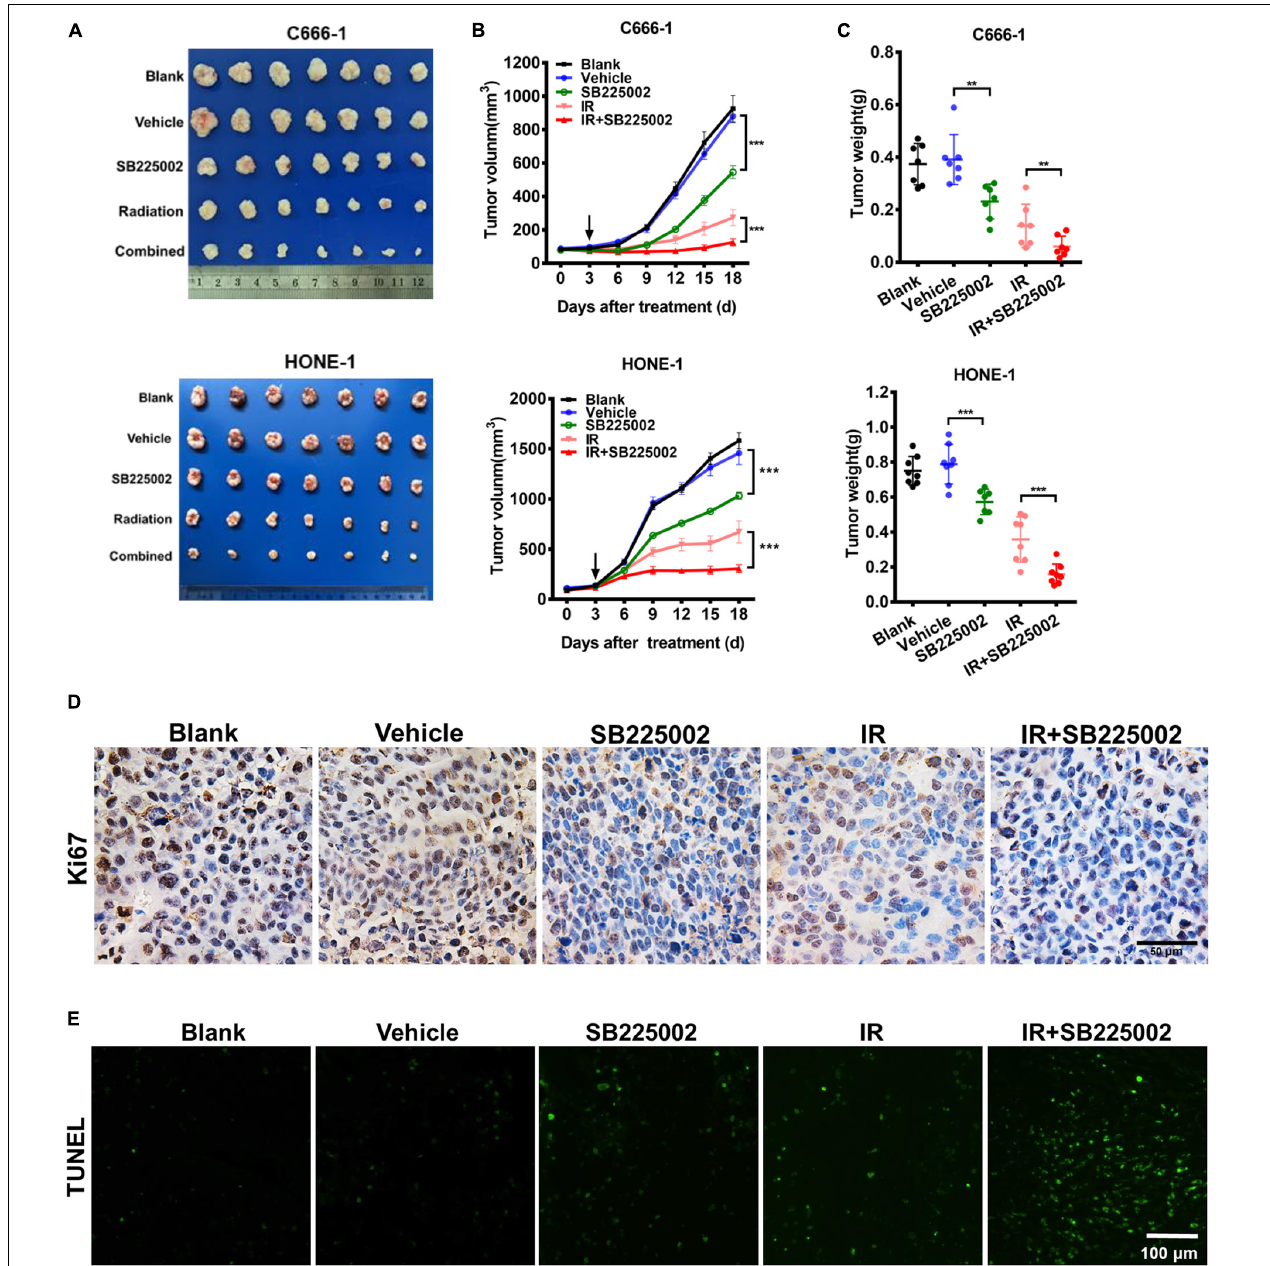
FIGURE 4 | SB225002 sensitizes tumor to radiation in vivo . C666-1 and HONE-1 cells were established subcutaneous in female BALB/c mice and SB225002 at 10 mg/kg and vehicle administration once daily were started 5 days after inoculation. A single dose of 8 Gy was administered at the 3th day of SB225002 administration. Tumor volumes and tumor weights were recorded every three days (seven mice per group). (A) Representative images of the xenograft tumors in five groups. Mice bearing C666-1 (Upper) and HONE-1-1 (Blow) tumors. (B) The growth curves of the tumors in five groups were presented. Data are shown as the mean tumor volume ± SD ( n = 7; *** p < 0.001; two-way ANOVA). (C) The antitumor and radiosensitization effects of SB225002 on the tumor weight in five groups were shown as mean ± SD ( n = 7; ** p < 0.01; *** p < 0.001; Student’s t -test). (D) Tumor cell proliferation was assessed by Ki67 immunohistochemical staining of paraffin-embedded C666-1 tumor sections ( n = 3; Scale bar, 50 µ m). (E) Tumor cell apoptosis was measured on paraffin-embedded C666-1 tumor sections by TUNEL staining ( n = 3; Scale bar, 100 µ